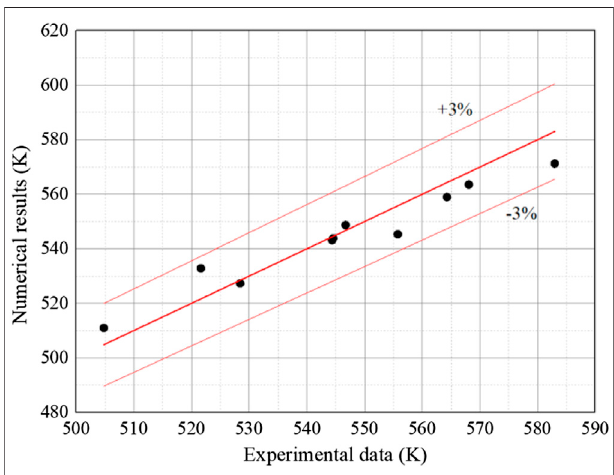
FIGURE 5 | The variations of numerical simulation errors.